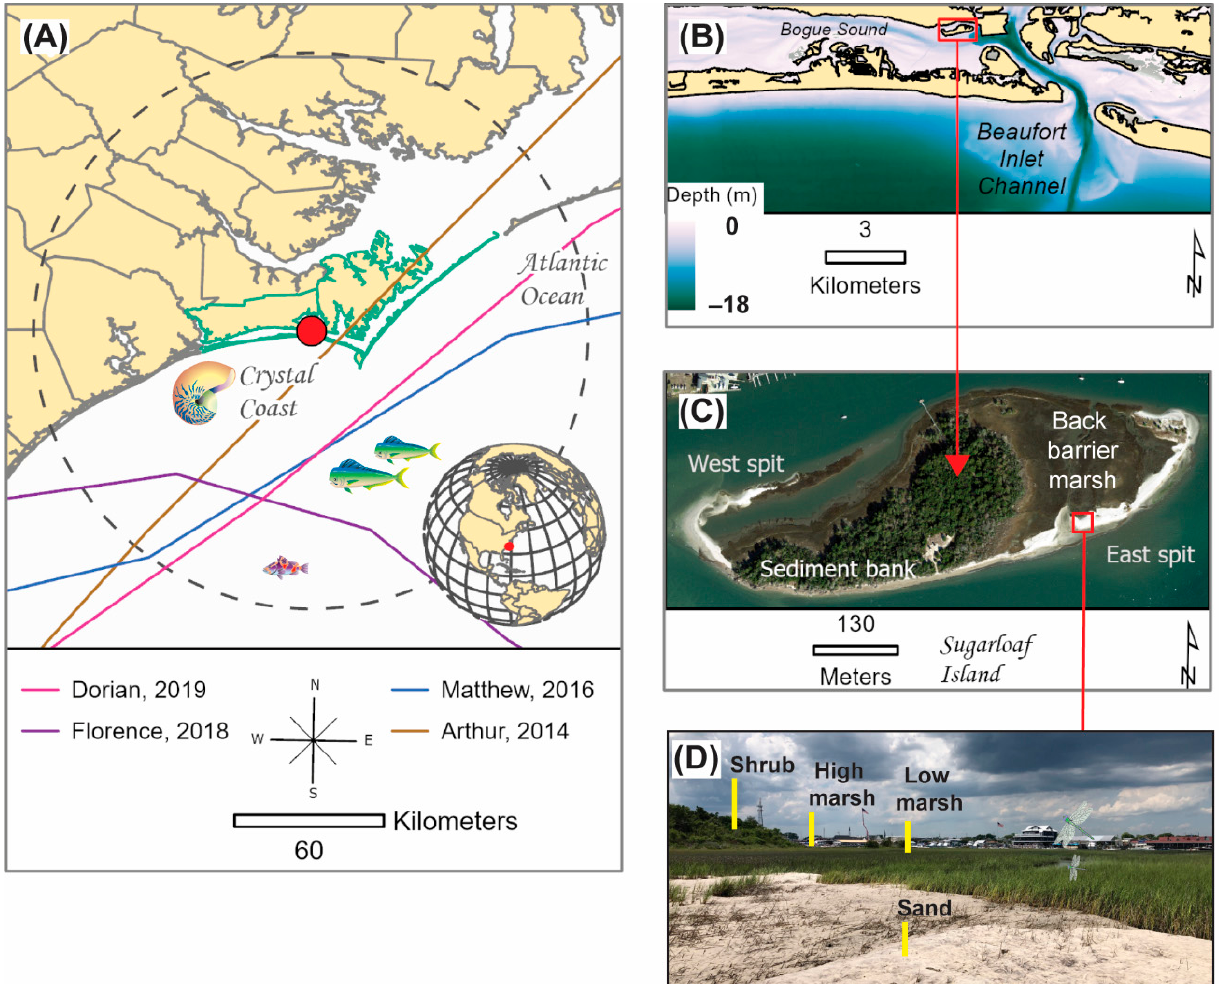
Figure 1. Maps of different scales of Sugarloaf Island located in North Carolina’s Crystal Coastal region. ( A ) The location of Sugarloaf Island is indicated by a red dot. The dotted circle denotes a 60 nautical mile radius from the Island where hurricanes passed. Hurricane-best-track data obtained from: https://www.nhc.noaa.gov/data/ (accessed on 25 October 2022), ( B ) 2010 bathymetry model from TCarta Marine LLC, ( C ) RGB aerial imagery from 2020, ( D ) visual line of sight captured while in the field in June 2022.